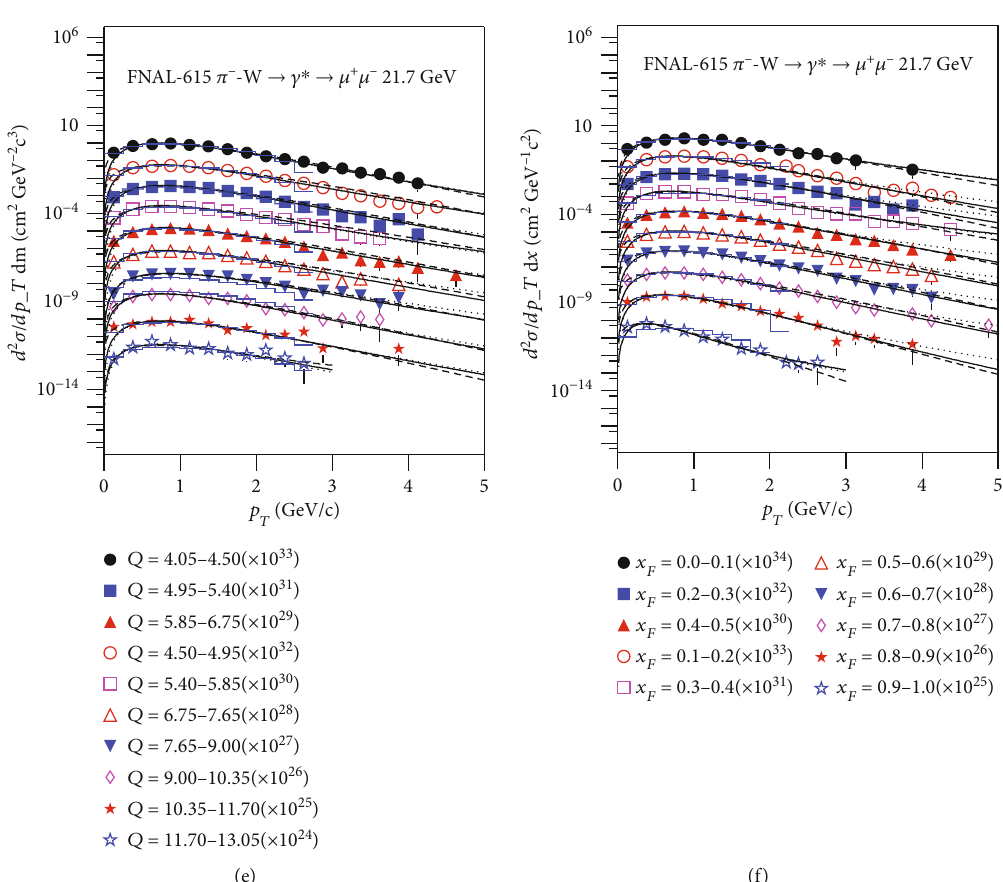
Figure 1: Transverse momentum spectra of ℓ (cid:1) ℓ (with di ff erent invariant masses Q or Feynman variables x F ) produced by the Drell-Yan process in di ff erent collisions at di ff erent energies. The data points in (a) – (c) are quoted from the E288 Collaboration [43] and obtained in ffiffi p p -Cu collisions at s = 19 : 4 GeV ( 4 ≤ Q < 9 GeV / c 2 ), 23.8GeV ( 4 ≤ Q < 13 GeV / c 2 ), and 27.4GeV ( 5 ≤ Q < 13 GeV / c 2 ), respectively. The ffiffi p s = 38 : 8 GeV performed by the E605 Collaboration [44]. The data points in (e) data points in (d) come from p -Cu collisions at ffiffi p s = 21 : 7 GeV measured by the FNAL-615 Collaboration ( 4 : 05 ≤ Q < 13 : 05 GeV / c 2 ) and (f) ( 0 : 0 ≤ x F < 1 : 0 ) come from π − -W collisions at (cid:1) ℓ (cid:1) ℓ [45], where the units GeV/ c 2 are not shown in (e) due to crowding space. In panel (d), ℓ is e + e − , and in other panels, ℓ is μ + μ − . The solid, dashed, and dotted curves are our results of fi tting the data points with the convolution of two Lévy-Tsallis functions [Eqs. (2) and (6)], the two-component Erlang distribution [Eq. (4)], and the convolution of two Hagedorn functions [Eqs. (5) and (6)], respectively, see text in subsection 3.3 for the meanings of histograms which are quoted from QCD